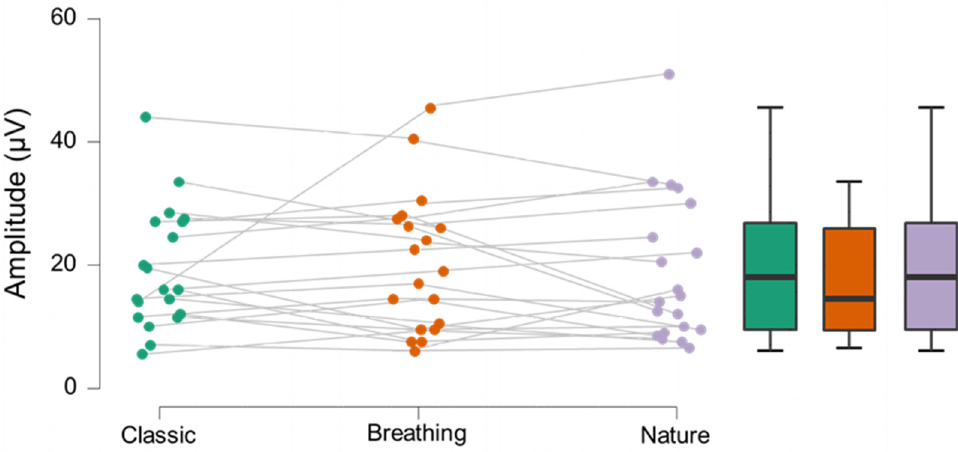
Figure 1. Individual and box plot data for protocol amplitudes in microvolts. No significant difference was observed.